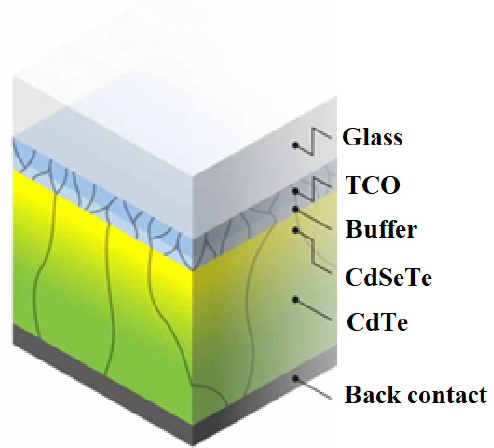
Figure 11. Schematic of a CdTe solar cell [1].